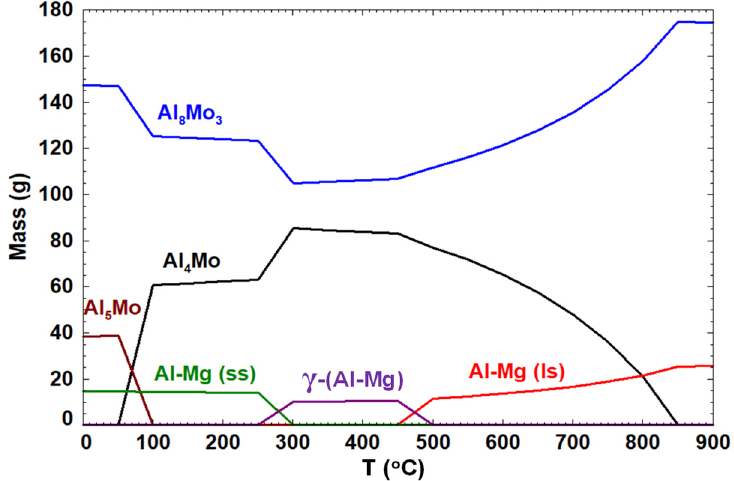
Figure 3. A FactSage™ prediction of the anti-wetting properties of solid metallic Mo in contact with molten Al-5 wt.%Mg alloy, with Al-Mg(ss) as a solid solution and Al-Mg(ls) as a liquid solution.